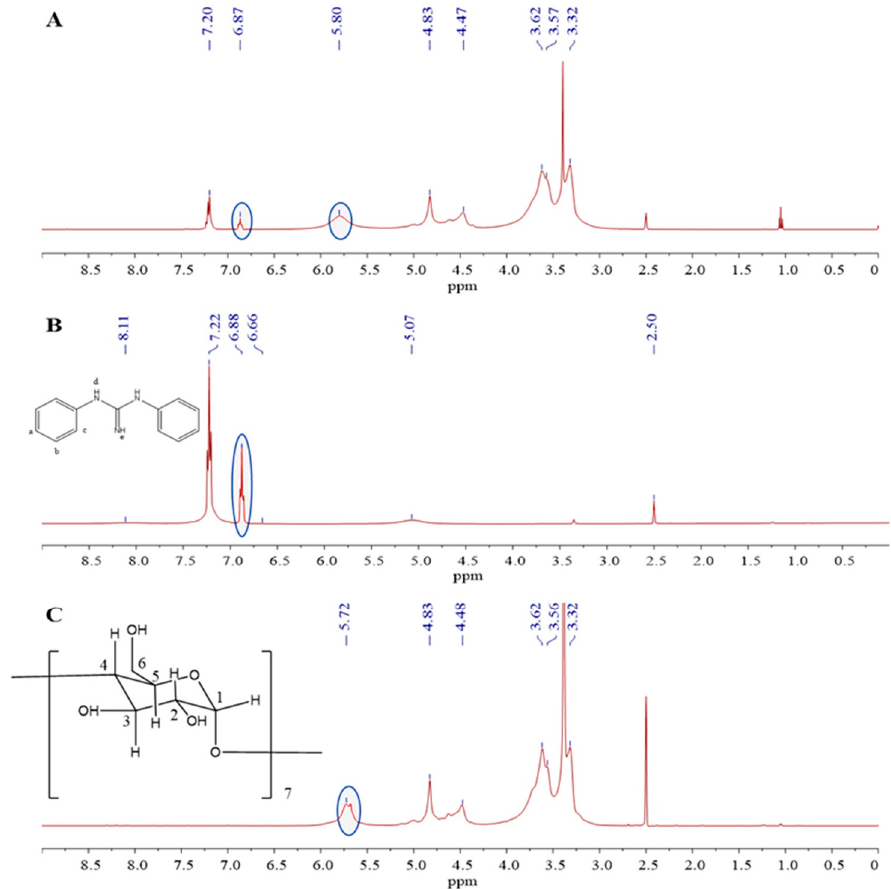
Figure 3. 1 H NMR spectra of ( A ) DPG- β -CDP, ( B ) DPG, and ( C ) β